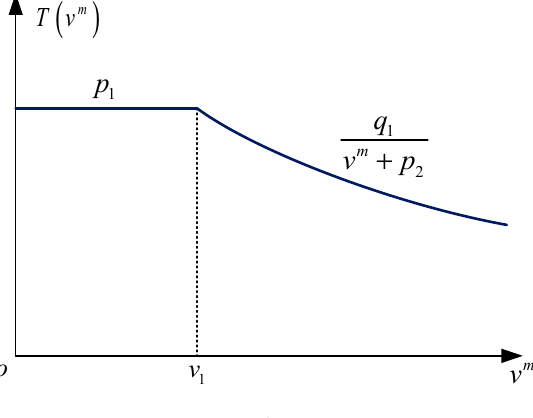
Figure 2. Traction characteristic curves.